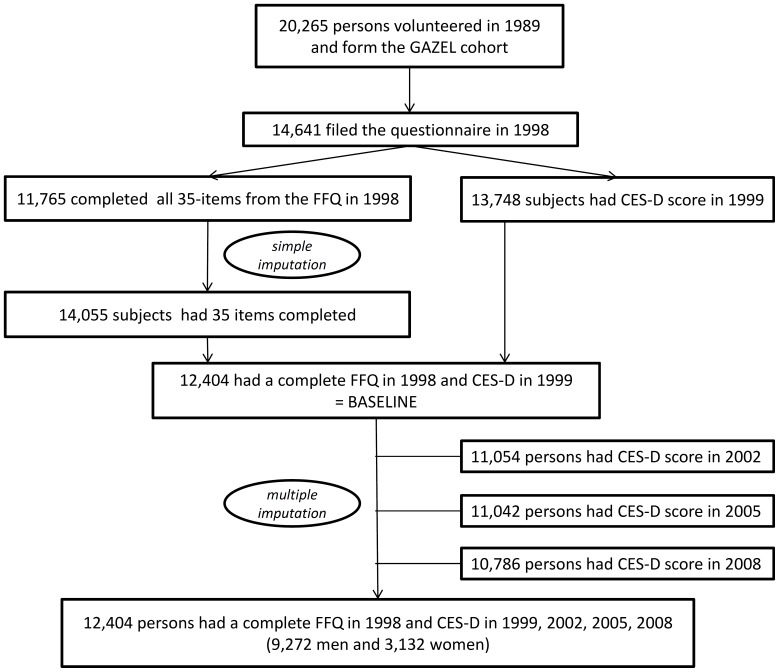
Flowchart describing the selection of participants in the study, Gazel cohort, 1989–2008.